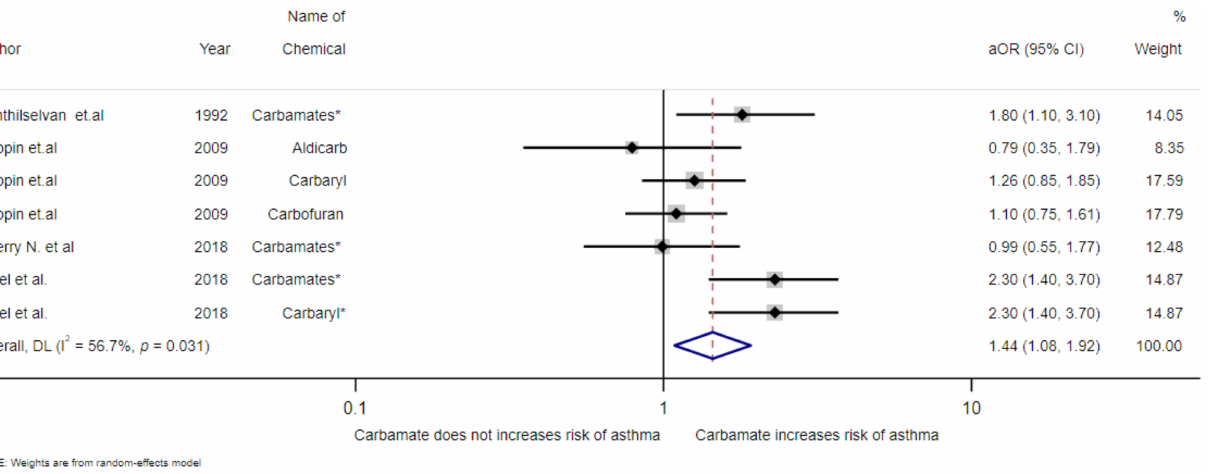
Figure 3. Meta-analysis of exposure to carbamates and asthma disease. * p < 0.05. The multivariable-adjusted ORs of exposure to organochlorines from all studies are shown in Figure 4. The pooled OR estimates found that organochlorines exposure was associated with an increased risk of asthmatic symptoms (OR = 1.31, 95%CI 1.19–1.64). Statistically significant heterogeneity was detected (I 2 = 37.3%, p =